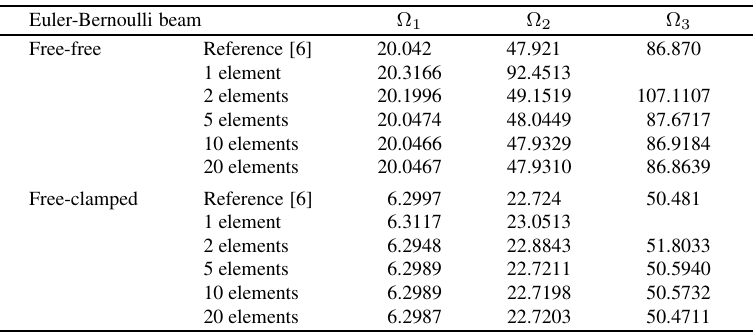
Table 3 First three natural fequencies of a wedge beam with parabolic tapered width and depth